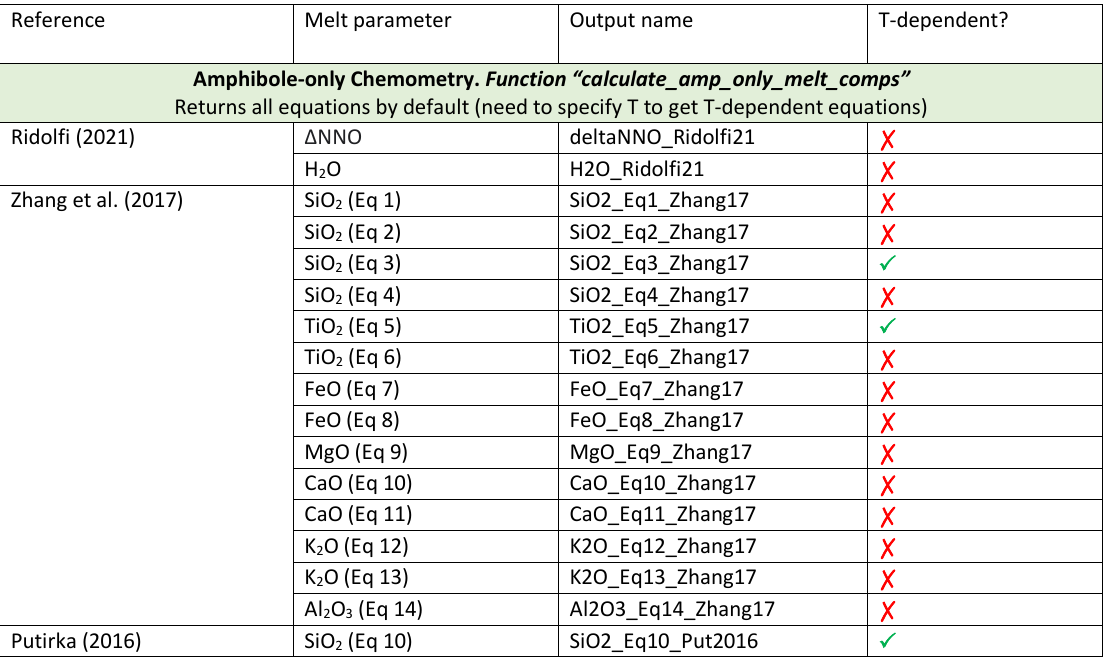
Table A7: Summary of equations for amphibole chemometers. From: Putirka 2016, Zhang et al. 2017, and Ridolfi 2021.